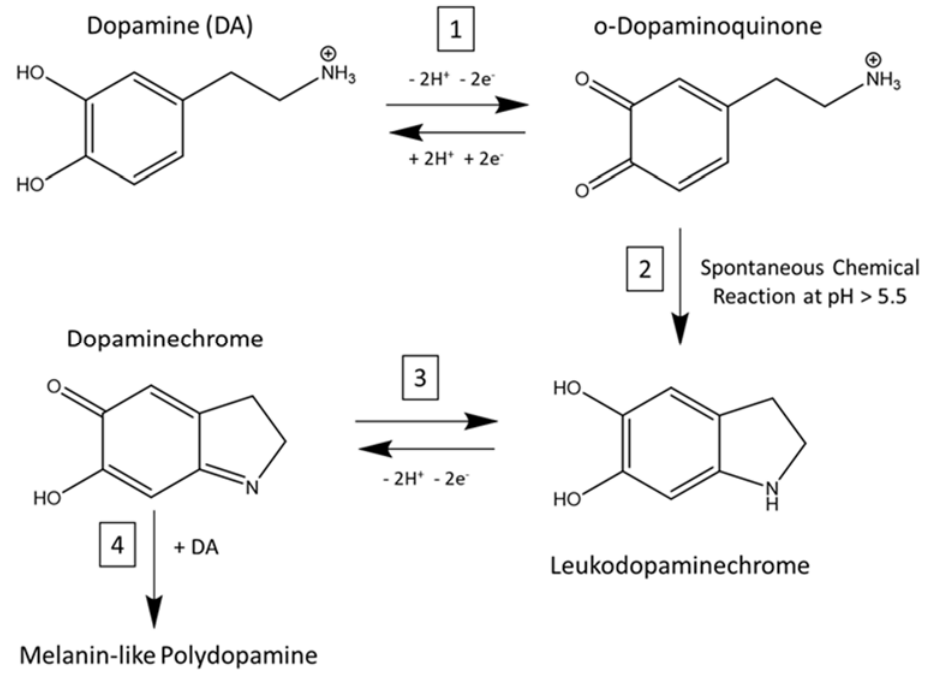
Figure 10. Reaction scheme for electrode fouling by electrochemical dopamine oxidation [17,61]. In Step 1, the electrode oxidation and reduction are assigned to the cyclic voltammetric (CV) waves of Figure 9A. Steps 2–4 are the spontaneous series of reactions that result in the formation of the insulating layer of melanin-like polydopamine.